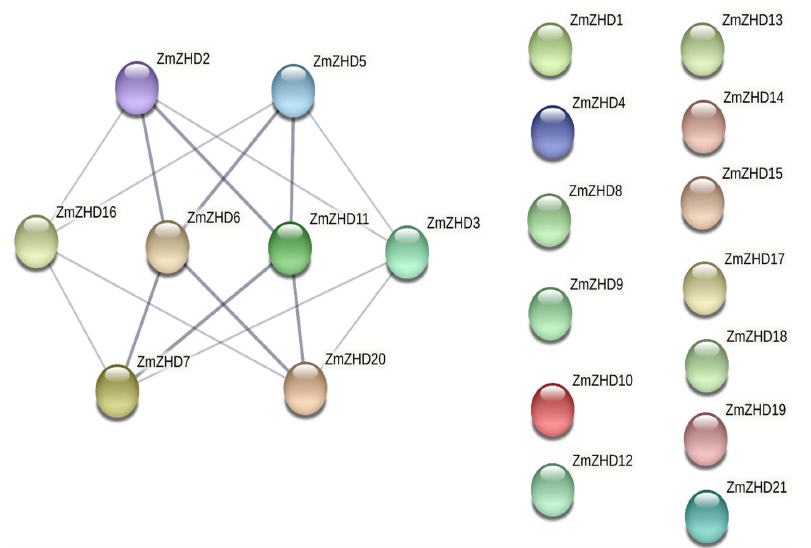
Figure 7. Interaction network of the ZHD proteins in Z. mays L. Deep ash-colored lines indicate the highest level of confidence (0.900), and faded ash-colored lines indicate a medium level of confidence (0.400). Lineless proteins do not have any relationship with other proteins. Protein–protein interactions (PPIs) play a crucial role in cellular functions and biological processes, including cell–cell interactions and metabolic and developmental control in all organisms. We performed in silico protein–protein interaction analyses within the family for phylogenetic profiling and to identify structural patterns and homologous pairs, intracellular localizations, and post-translational modifications among the proteins. Furthermore, we considered the interaction and involvement of major signalling or stress pathways, though we avoid discussion of these subjects due to their complexity.